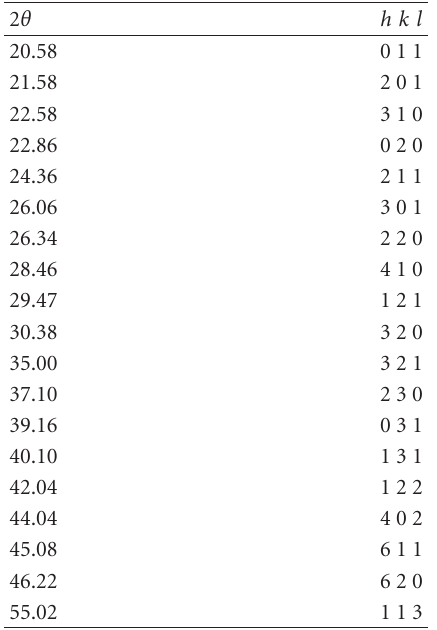
Table 6: 2 θ and ( h k l ) values of L-threonine and its deuterated